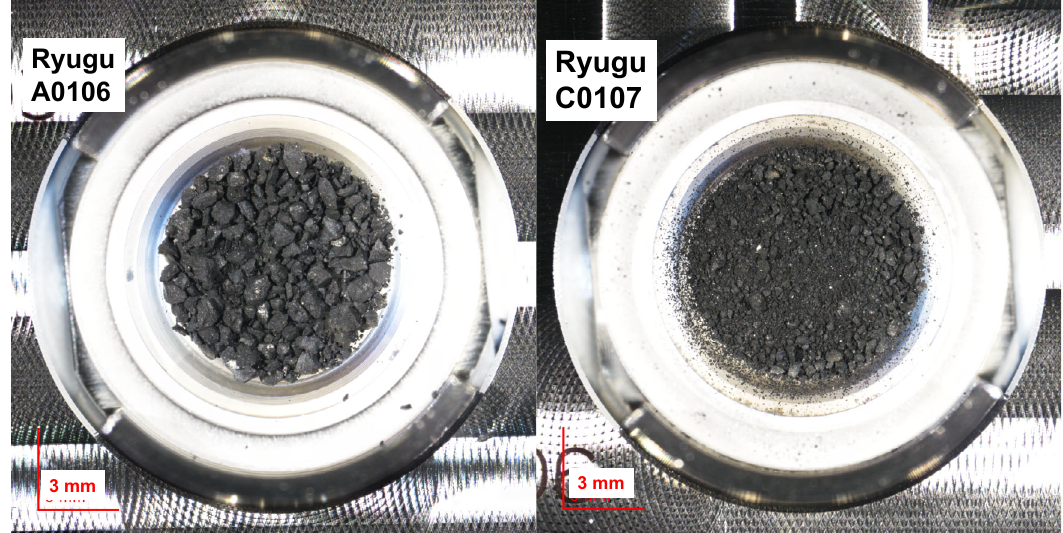
Fig. 1 | Sample returned from asteroid Ryugu (162173). Photographs of initial samplesA0106(total38.4mg) 6 andC0107(total37.5mg) from the asteroid Ryugu (162173) during the 1 st touchdown sampling and 2 nd touchdown sampling,